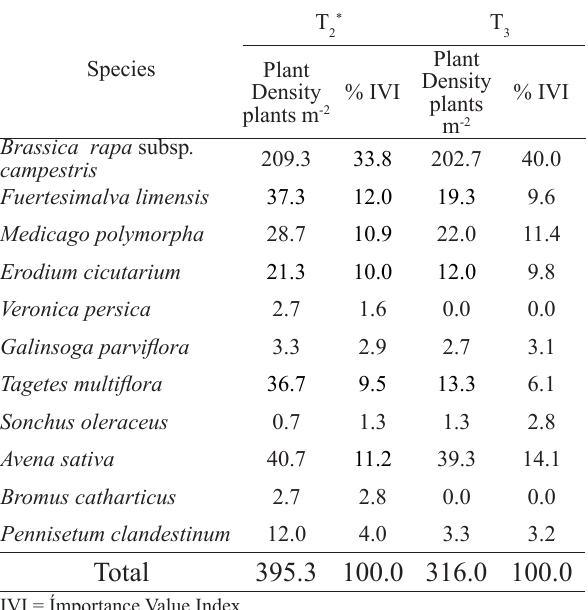
Tabla 5. Density and Importance Value Index of